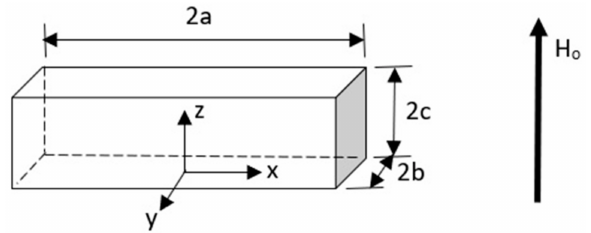
Figure A1. Rectangular prism subjected to uniform magnetic field H o